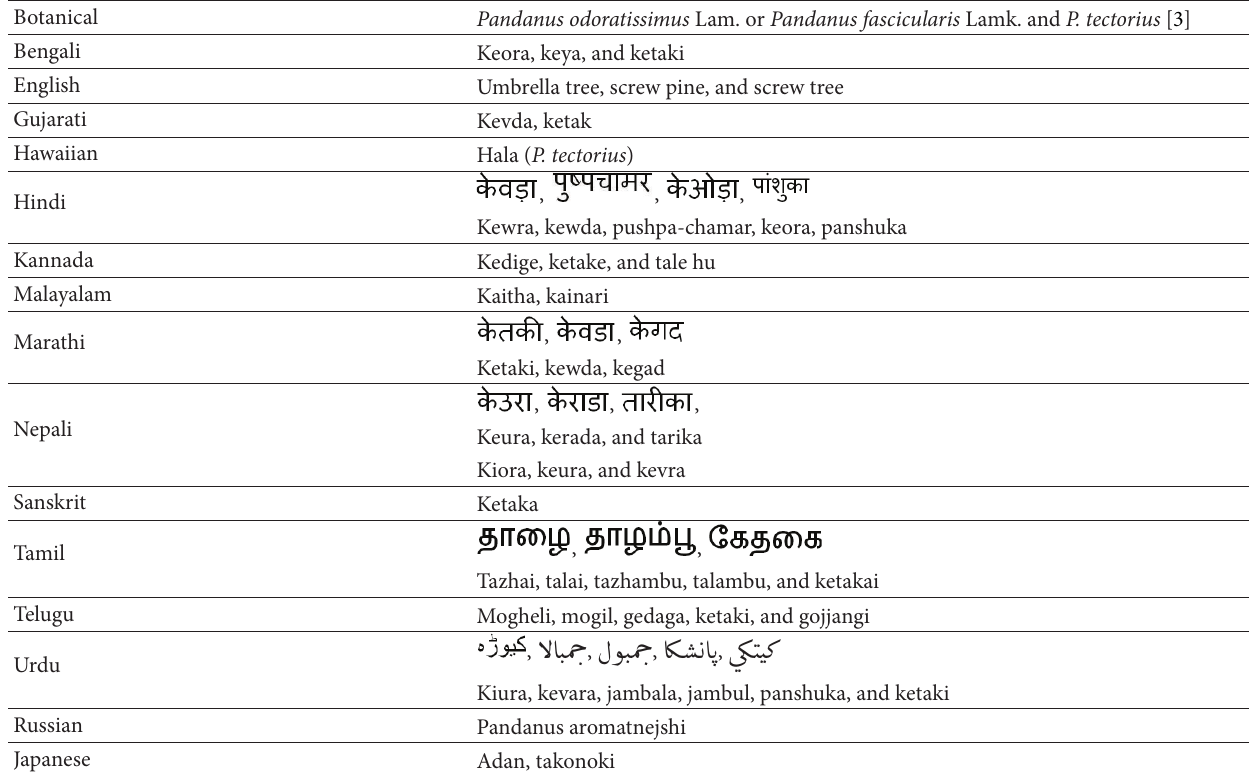
Table 1: Synonyms of Pandanus odoratissimus